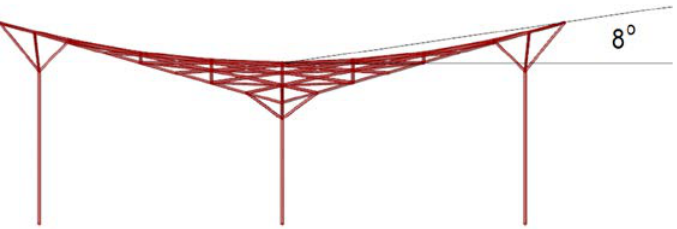
Figure 6. Determination of the roof inclination angle.